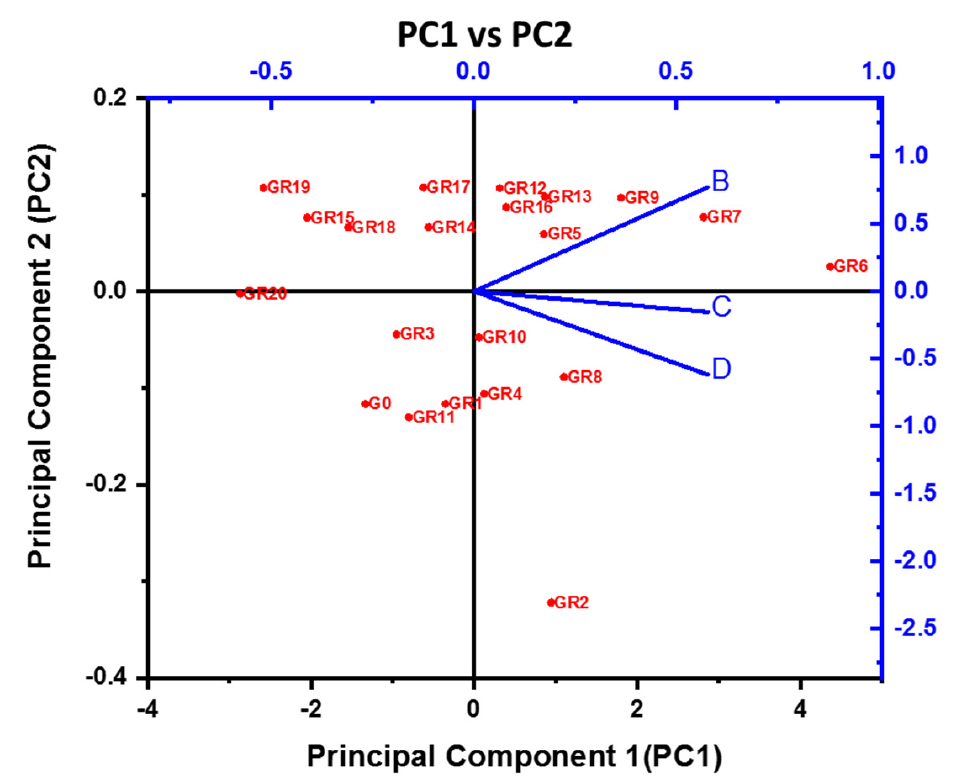
Figure 14. Principal component plot CS values.